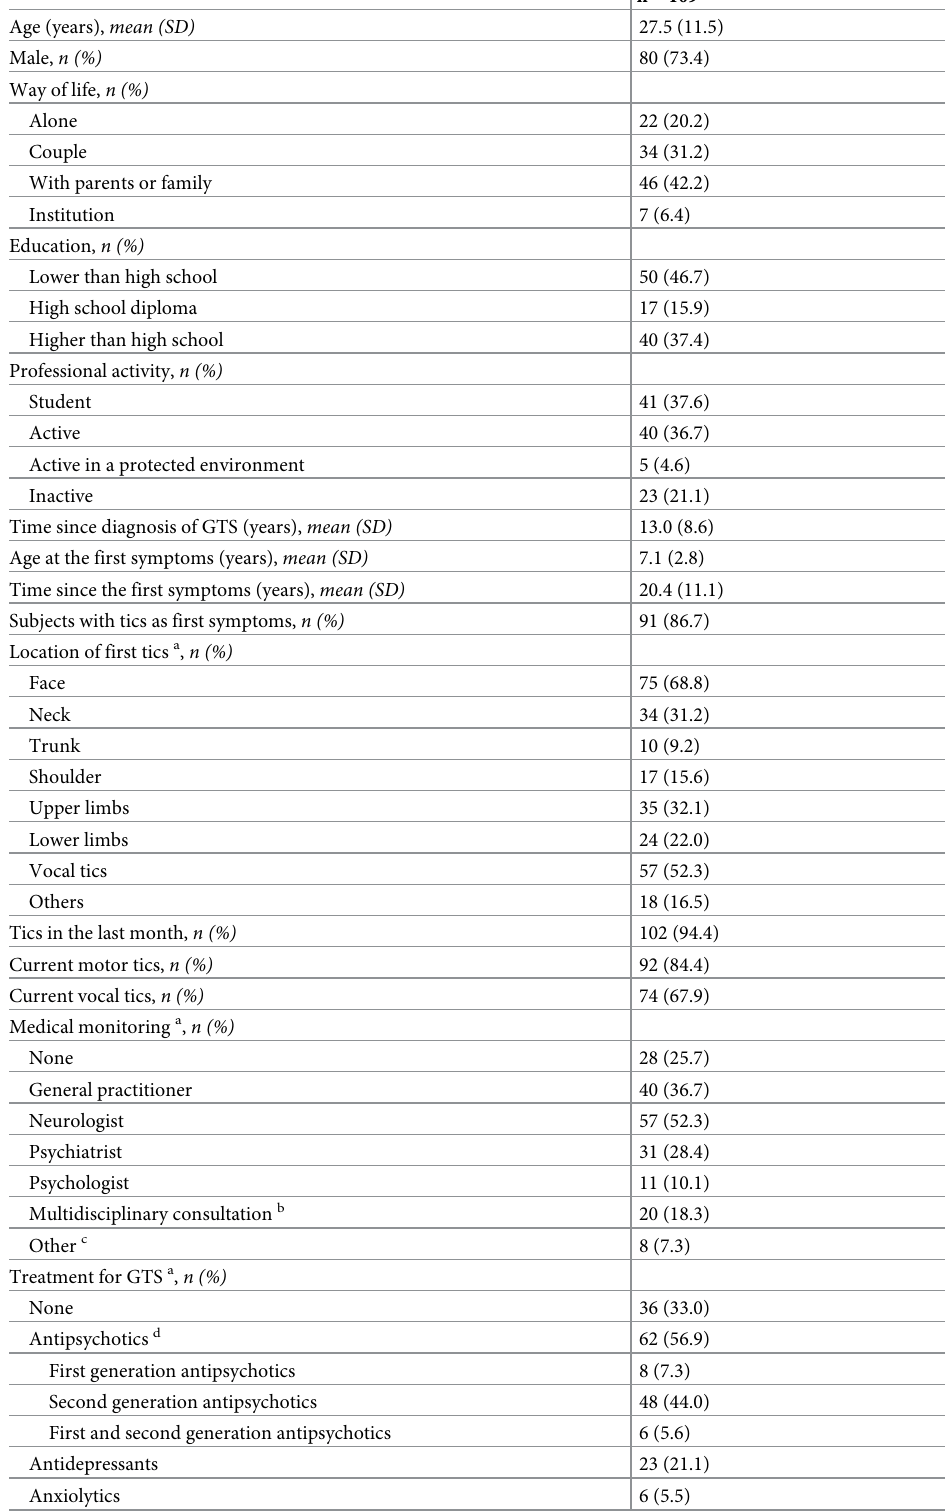
Table 1. Sociodemographic and clinical characteristics of the